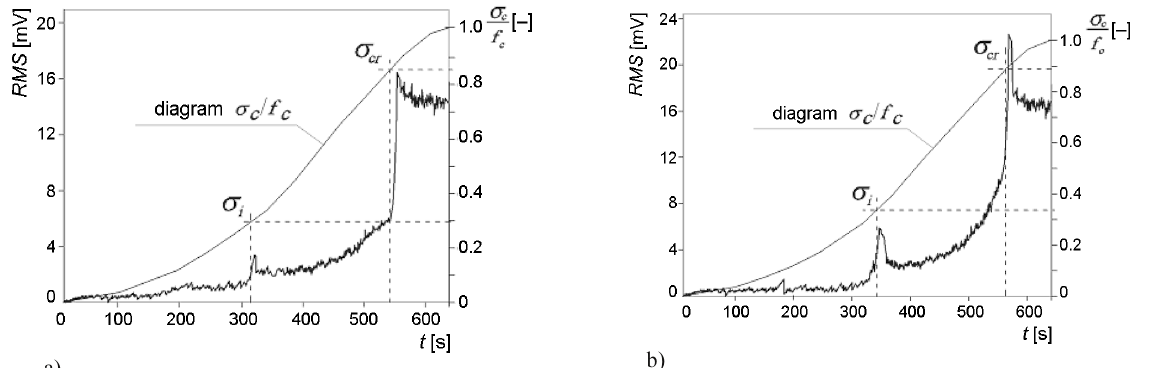
Fig. 11. RMS AE signal, referred to relative compressive strength σ c /f c , versus failure time for self-compacting concrete: a) B/S A ; b) D/S V